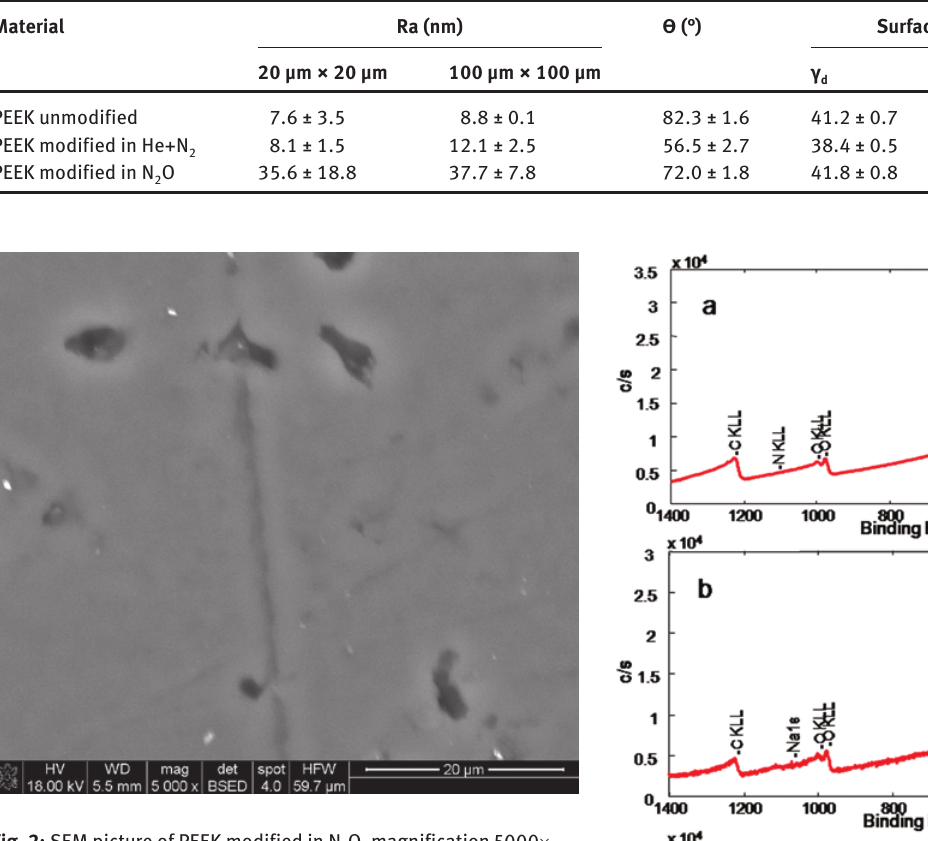
Fig. 2: SEM picture of PEEK modified in N 2 O, magnification 5000 × .